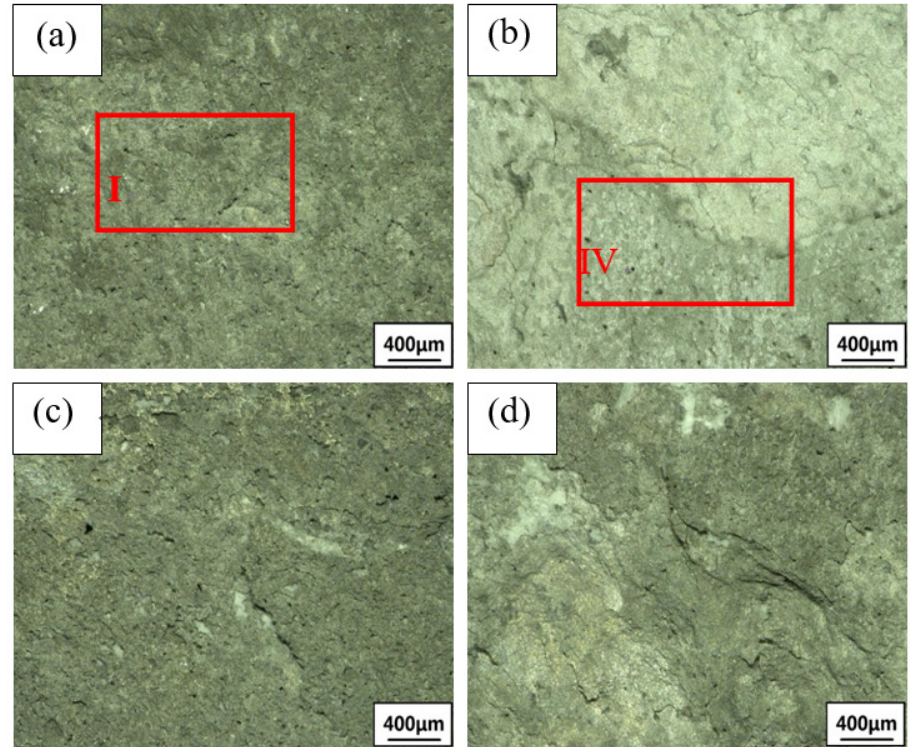
Figure 10. Corrosion morphology of the 2024 FSWed joints with different deformations after 48 h